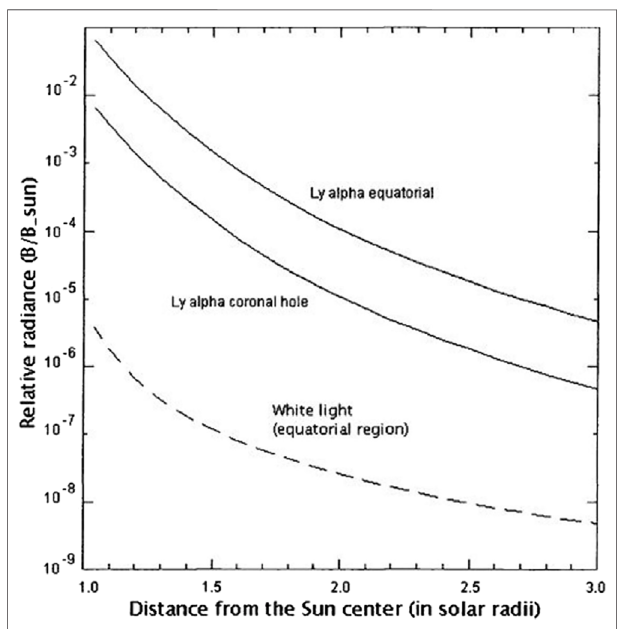
FIGURE 2 | Brightness of the corona compared to the solar disk in Lyman-alpha and white-light wavebands.